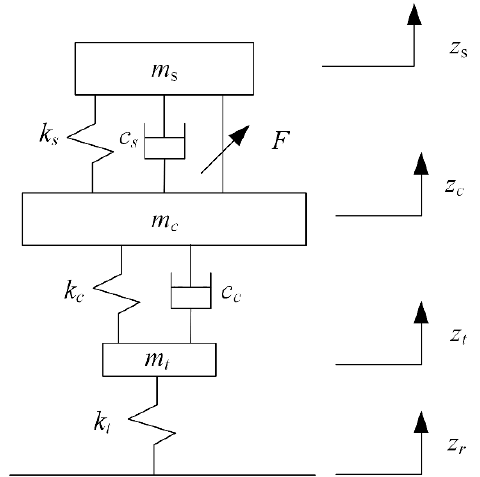
Figure 5. Three-degrees-of-freedom model of “ seat – body – tire ” system with electromagnetic force. It is assumed that the disturbances of uncertain factors such as a sudden voltage change are ignored, that is, the seat is only subject to the excitation electromagnetic